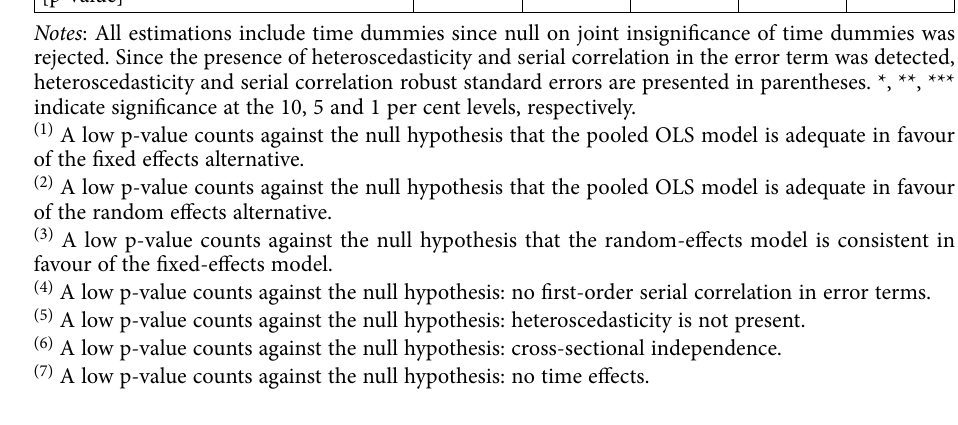
Table 4. Fixed effects estimates of Eq.